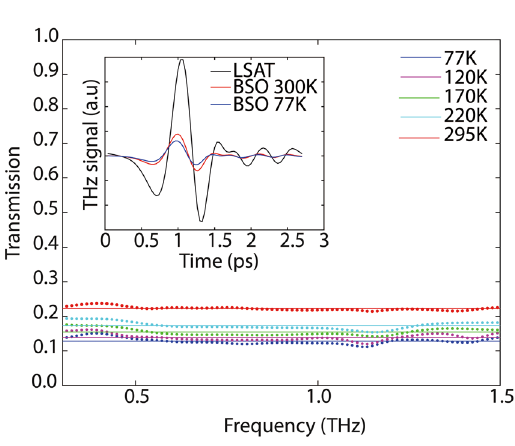
Figure 1. Measured optical transmission through a 132-nm film of stoichiometric La-doped BSO with a 132 nm buffer BSO layer grown on a STO substrate (blue trace) as well as optical transmission through a STO bare substrate (red trace) in the visible spectrum. Fitted curves for the measured data to the model described in the Methods section are indicated by dashed lines. The right inset shows the extracted refractive indices for BSO and the STO substrate extracted from this fitting. The left inset shows a picture of one of the analyzed samples showing its transparency.